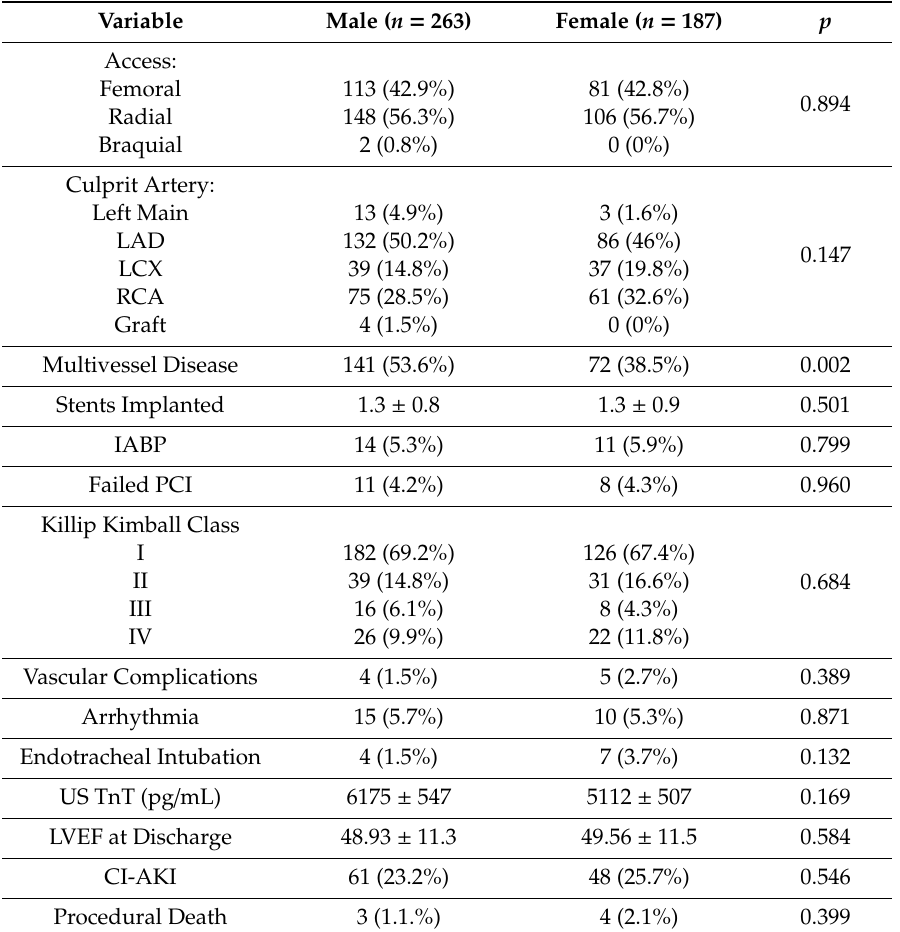
Table 2. Intra-procedural characteristics.